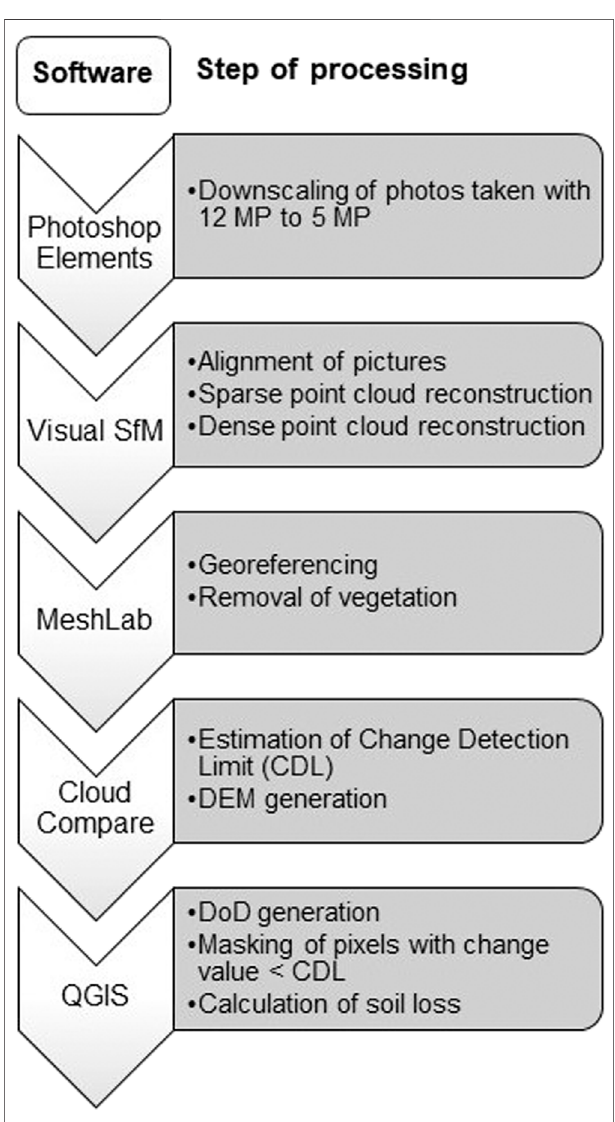
FIGURE 3 | Work fl ow of SfM-photogrammetry data